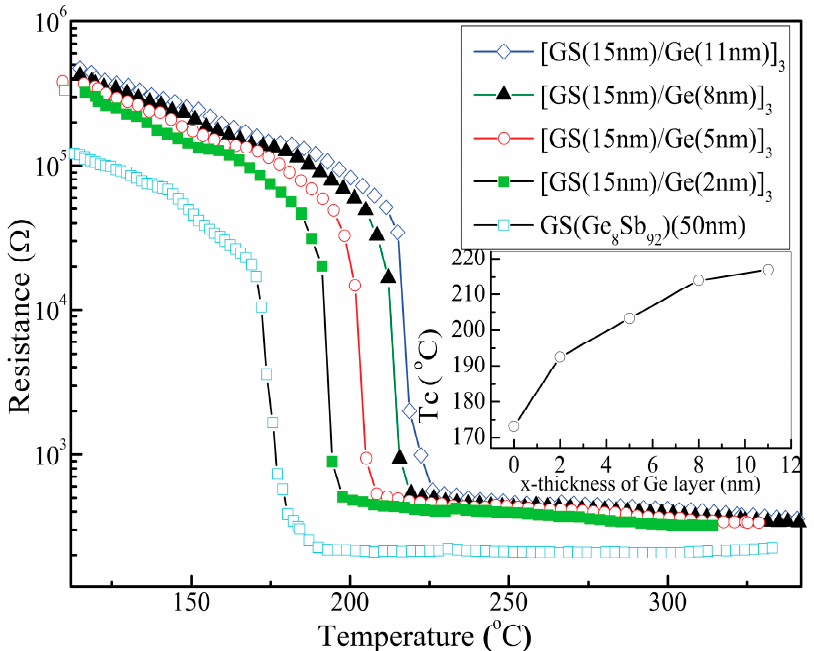
Figure 1. Sheet resistance of four superlattice-like (SLL) films [Ge 8 Sb 92 (15 nm)/Ge(x nm)] 3 (x = 2, 5, 8, 11) and a single layer film Ge 8 Sb 92 (50 nm) as a function of temperature. In the legend, GS denotes Ge 8 Sb 92 films.